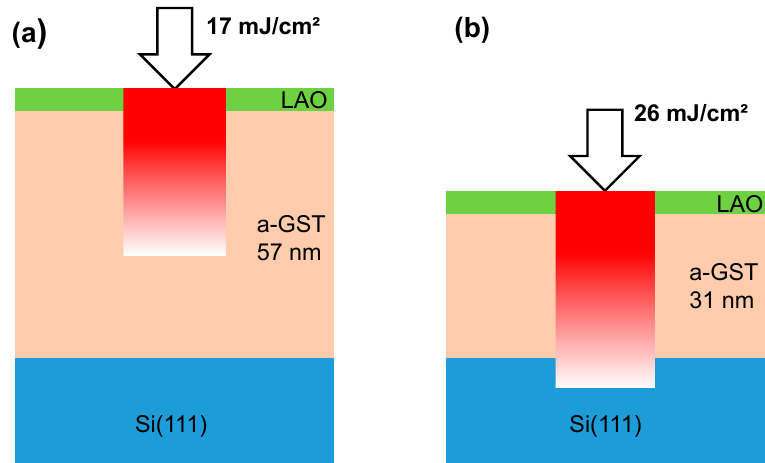
Figure 3. Scheme for the investigation of the effect of interfaces on the crystallization of GST thin films during ns-laser irradiation. The figure shows approximately the propagation of the laser beam in the GST thin films. ( a ) Illustration of the experiment on UV laser irradiation of an amorphous GST thin film of thickness 57 nm by a ns-laser pulse with a fluence of 17 mJ/cm 2 ; ( b ) Representation of the experiment on UV laser irradiation of an amorphous GST thin film of thickness 31 nm by a ns-laser pulse with a fluence of 26 mJ/cm 2 .